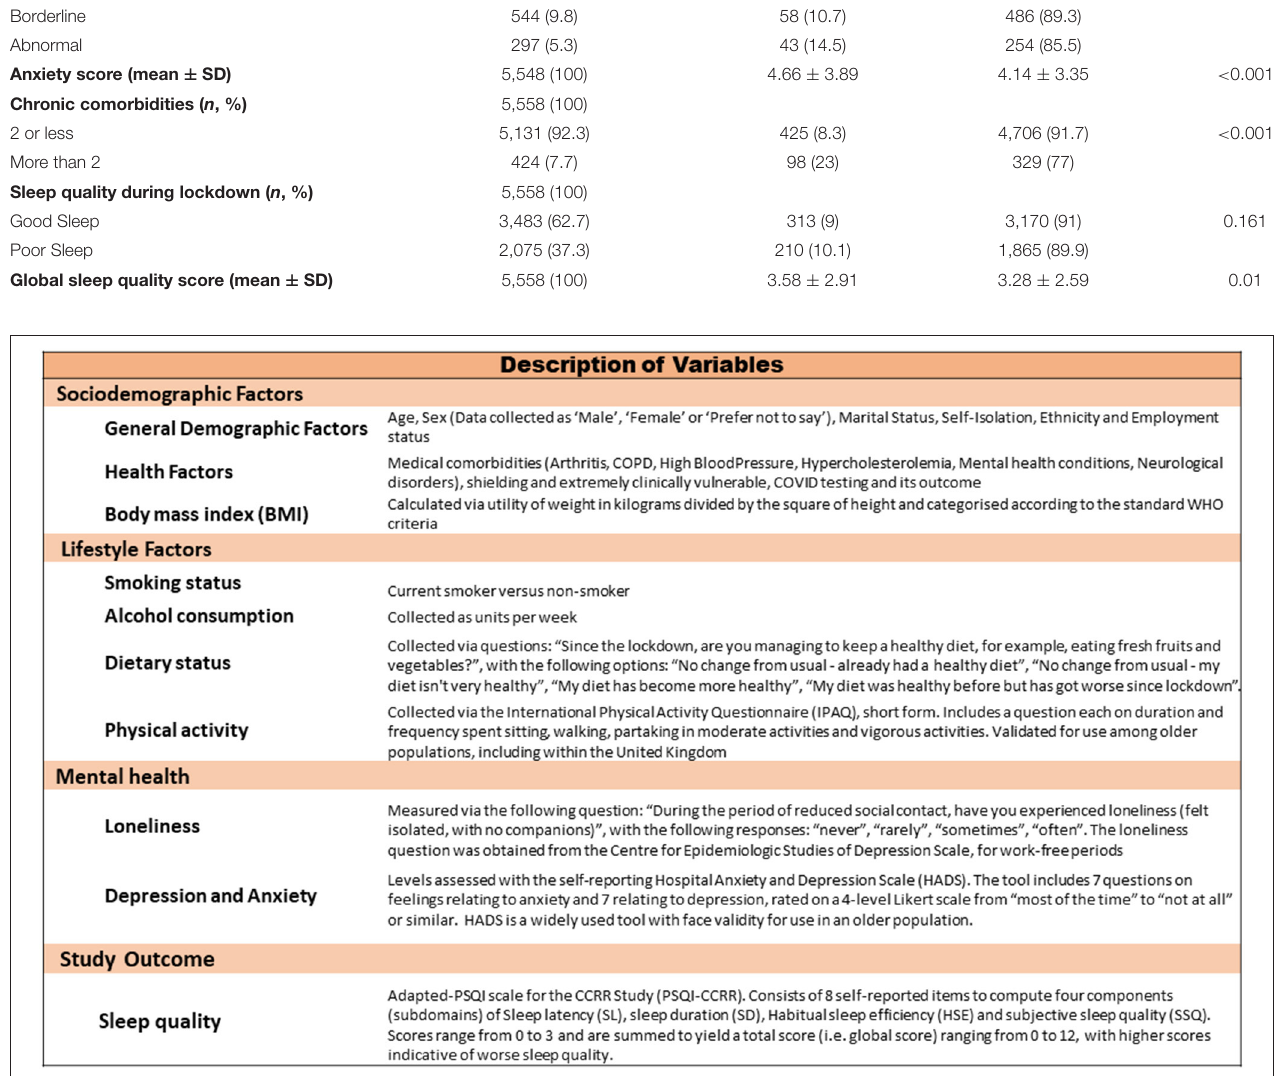
FIGURE 1 | Descriptive summary of study measures.